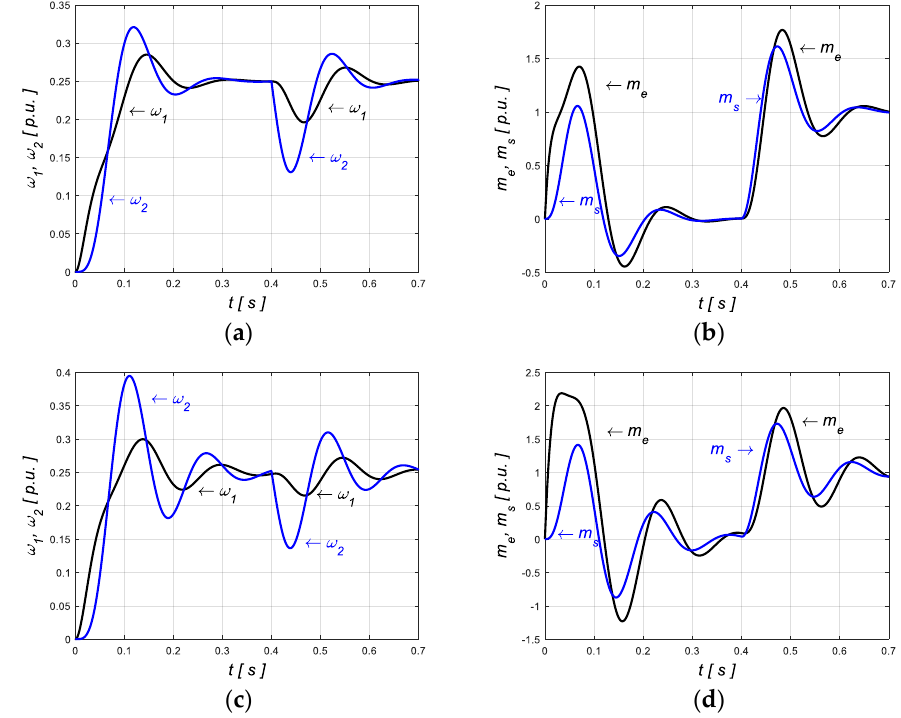
Figure 3. Transients of the two-mass system: motor and load speed ( a , c ), electromagnetic and shaft torque ( b , d ) for different value of the inertia ratio coefficients R = 1 ( a , b ) and R = (0.5).